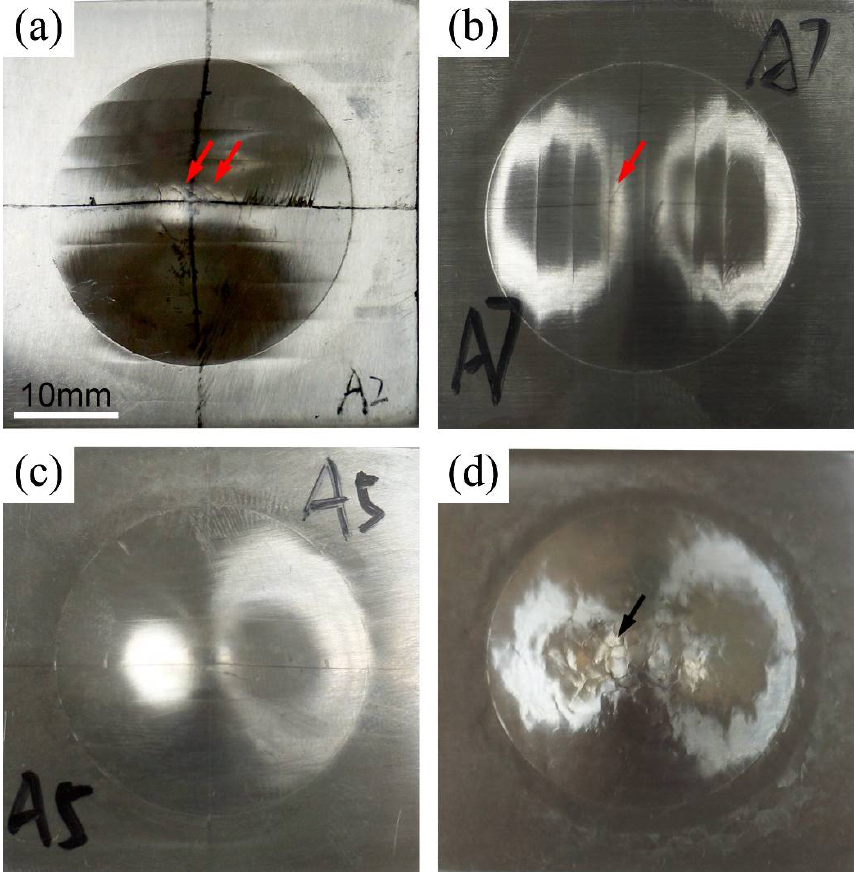
Figure 4. Macroscopic appearances of the M-FSP plates after Erichsen cupping tests at different punching speeds of ( a ) 0.1 mm/min; ( b ) 1 mm/min; ( c ) 10 mm/min; and ( d ) BM tested at 1 mm/min.